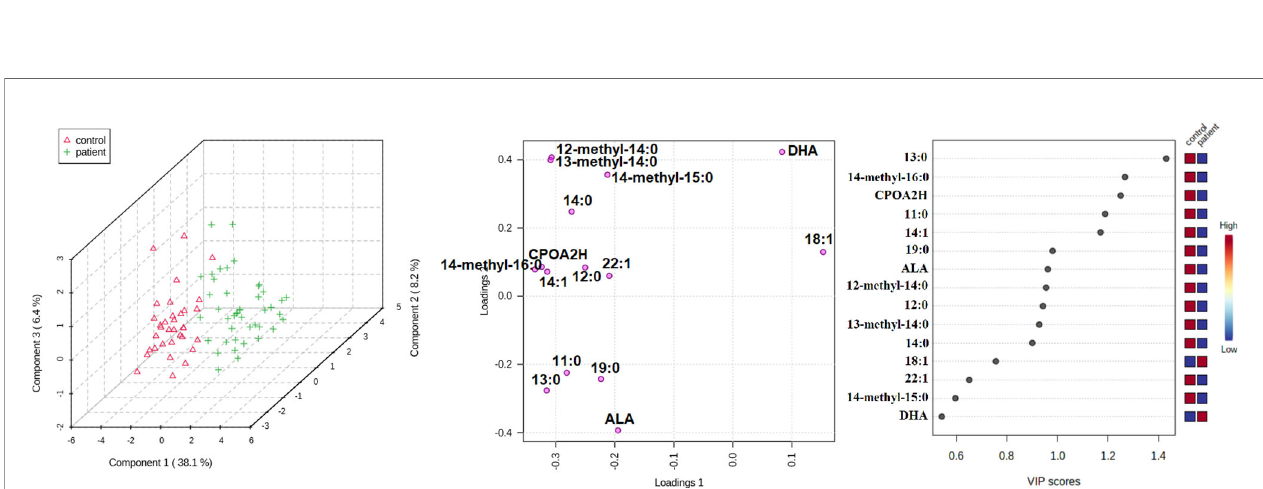
FIGURE 3 | Heatmap representing the relative levels of fatty acids among two tested groups. Warm colors on the heatmap indicate high content of a given FA in relation to the mean value in the whole dataset, while cold colors represent its low content when compared to the average. The serum samples of CRC patients and HCs are represented by blue and red, respectively.